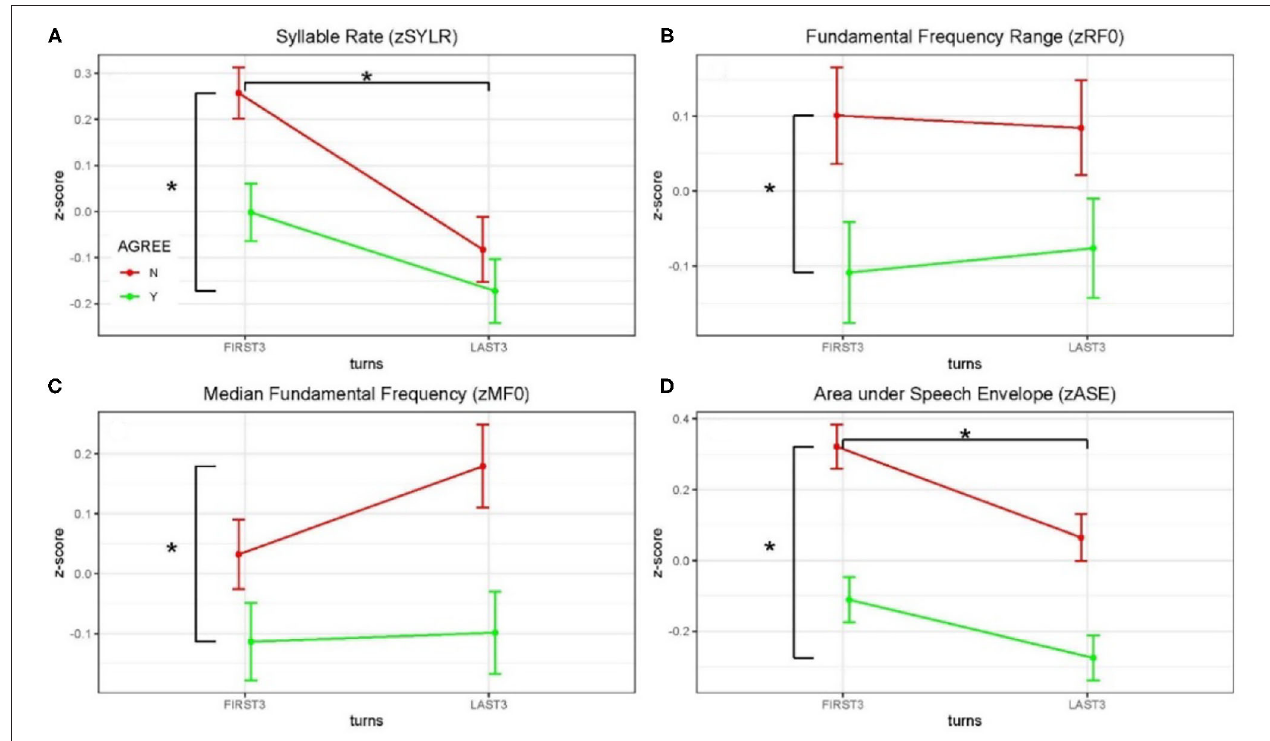
FIGURE 3 | Z-scored audio behavioral measures grouped by agreement (yes or no) and turn (first three turns and last three turns); error bars show standard error of the mean (SEM). Asterisks mark significant comparisons per LMM results. Green represents agree (Yes) and red represents disagree (No). (A) Shows syllable rate (syllables/s); (B) shows median fundamental frequency (F0) in Hz; (C) shows F0 range (Hz); and (D) shows area under the speech envelope normalized by turn duration (acoustic